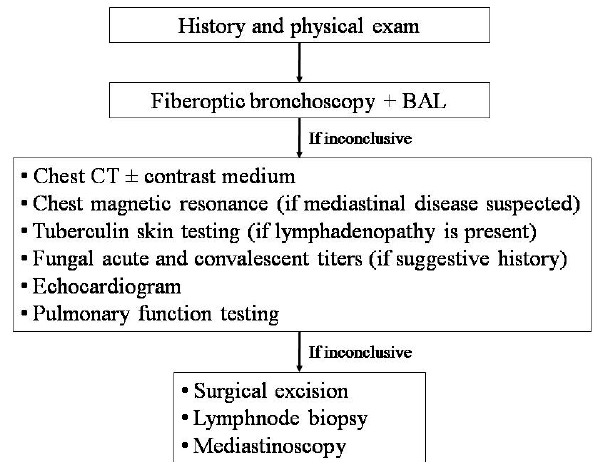
Figure 2. Diagnostic approach to children with recurrent pneumonia in the same area. BAL, bronchoalveolar lavage; CT, computed tomography.